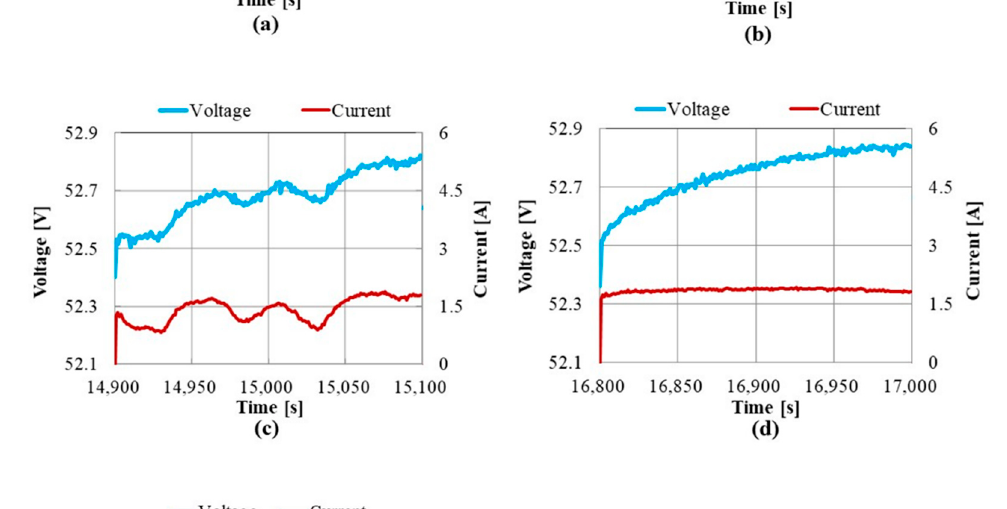
Figure 19. Battery voltage and current waveforms of the DC distribution system. ( a ) Case 1. ( b ) Case 2. ( c ) Case 3. ( d ) Case 4. ( e ) Case 5.